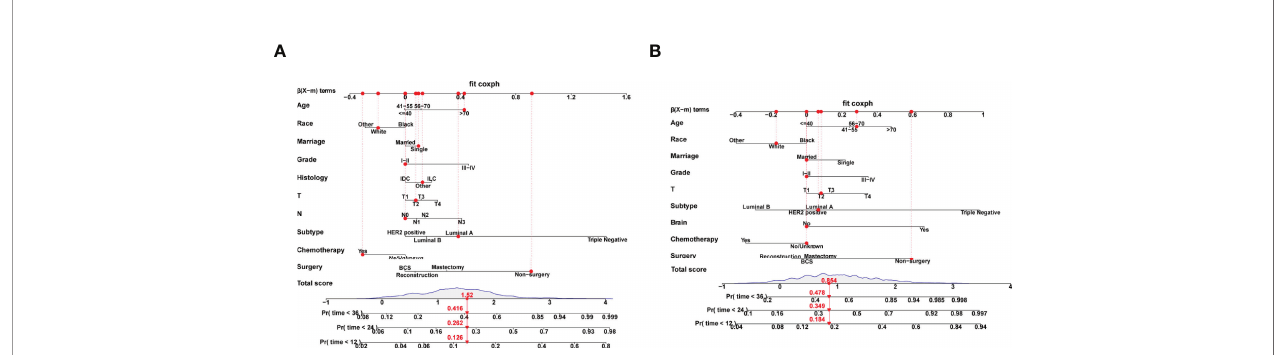
FIGURE 4 | (A) Competing risk nomogram in the bone-only metastatic pattern. (B) Competing risk nomogram in the viscera pattern.